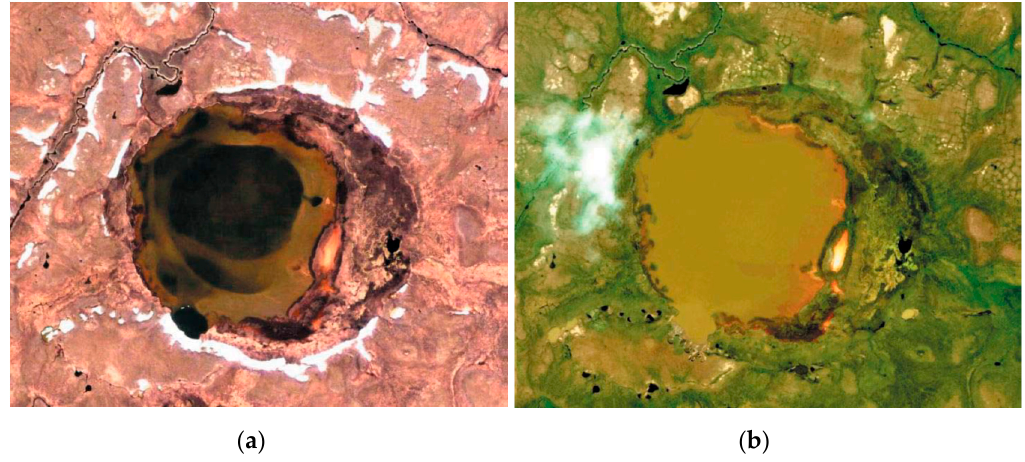
Figure 3. Satellite images of Crater Lake south of Bovanenkovo field: ( a ) 4 July 2009 and ( b ) 21 July 2013 (number on the map: 2) [10].